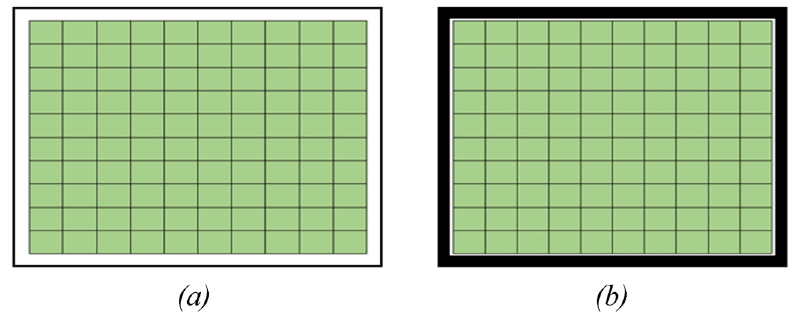
Figure 13: Representation of conventional boundary conditions ( a ) SSSS and ( b ) CCCC.